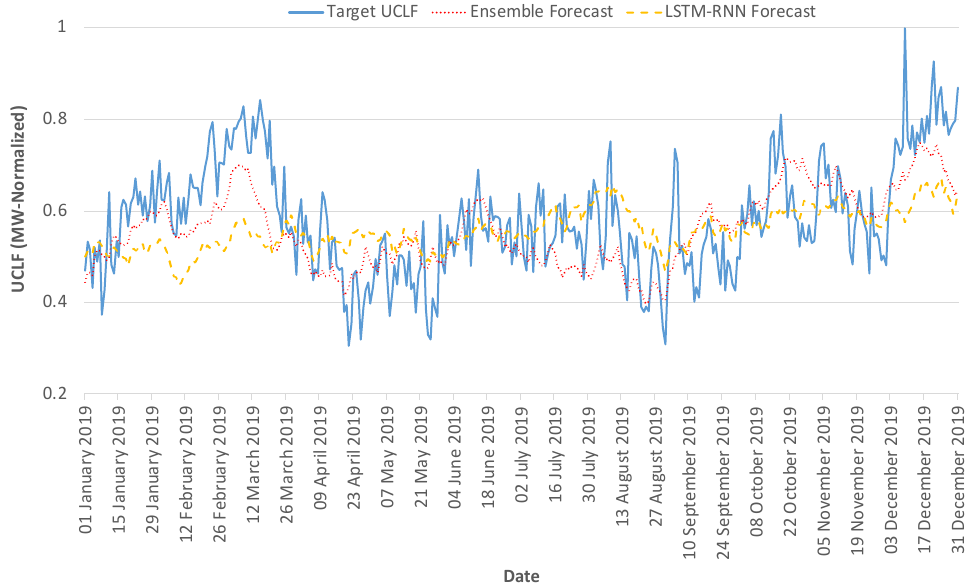
Figure 9. A plot of the LSTM-RNN and ensemble lowest error model year-ahead UCLF forecast against the target UCLF.